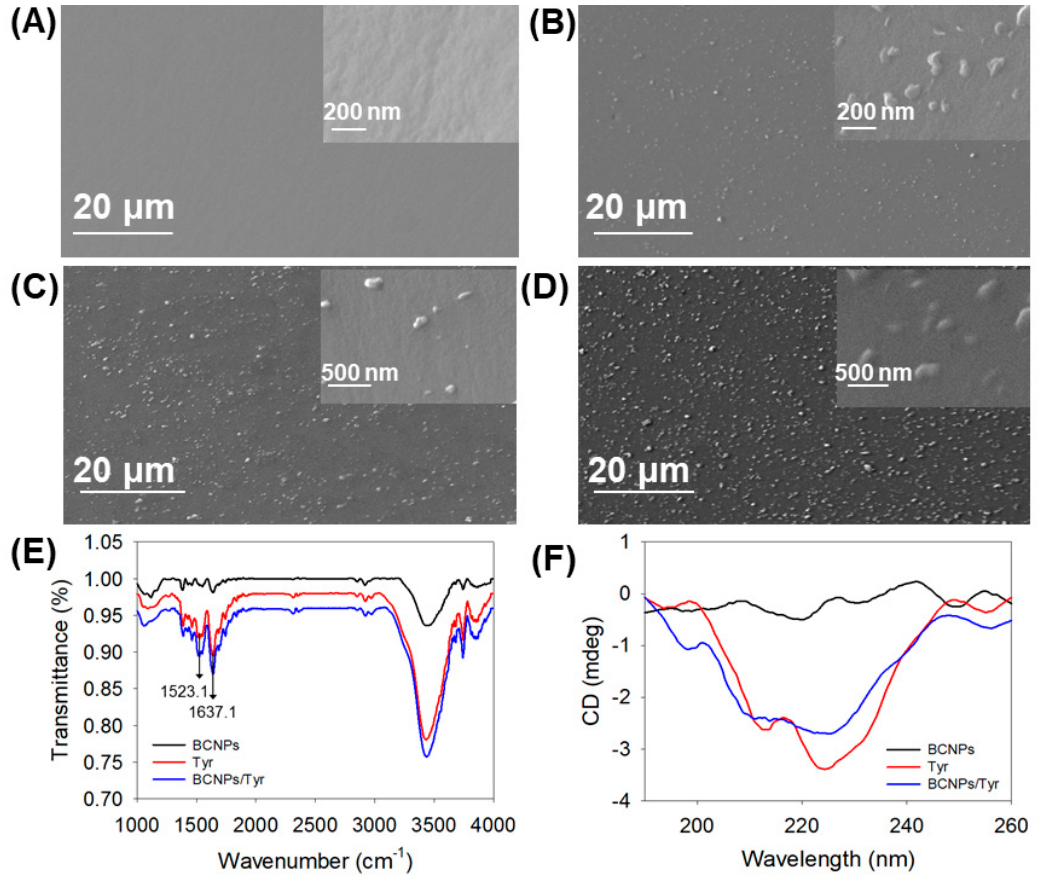
Figure 1. SEM images of ( A ) GCE, ( B ) BCNPs/GCE, ( C ) BCNPs/Tyr/GCE, ( D ) BCNPs/Tyr/Nafion/GCE. ( E ) FTIR spectra of BCNPs , Tyr and BCNPs/Tyr. (F) CD spectra of BCNPs, Tyr and BCNPs/Tyr.